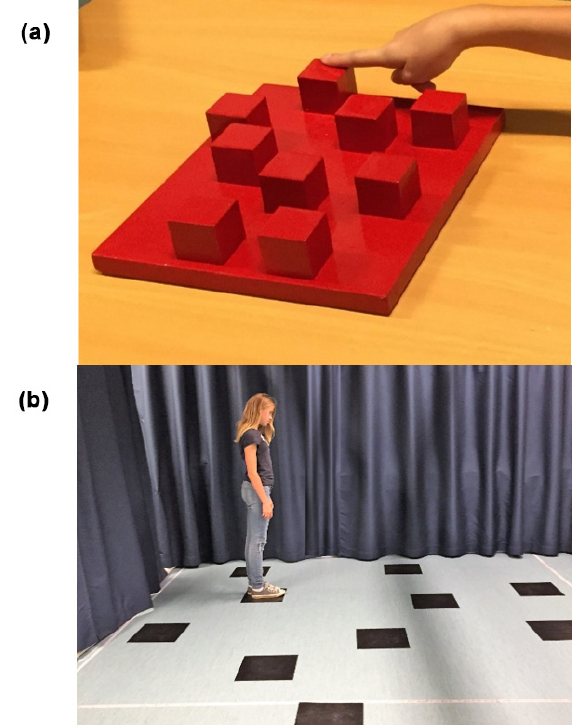
Figure 1. ( a ) The Corsi Block-Tapping test (CBT) consists of nine blocks (4.5 × 4.5 cm) constructed on a baseboard (30 × 25 cm) with numbers observable on the examiner’s side; ( b ) a child performing the Walking Corsi Test (WalCT) on a 300 × 250 cm surface on the floor with nine squares positioned in equal positions as in the CBT.